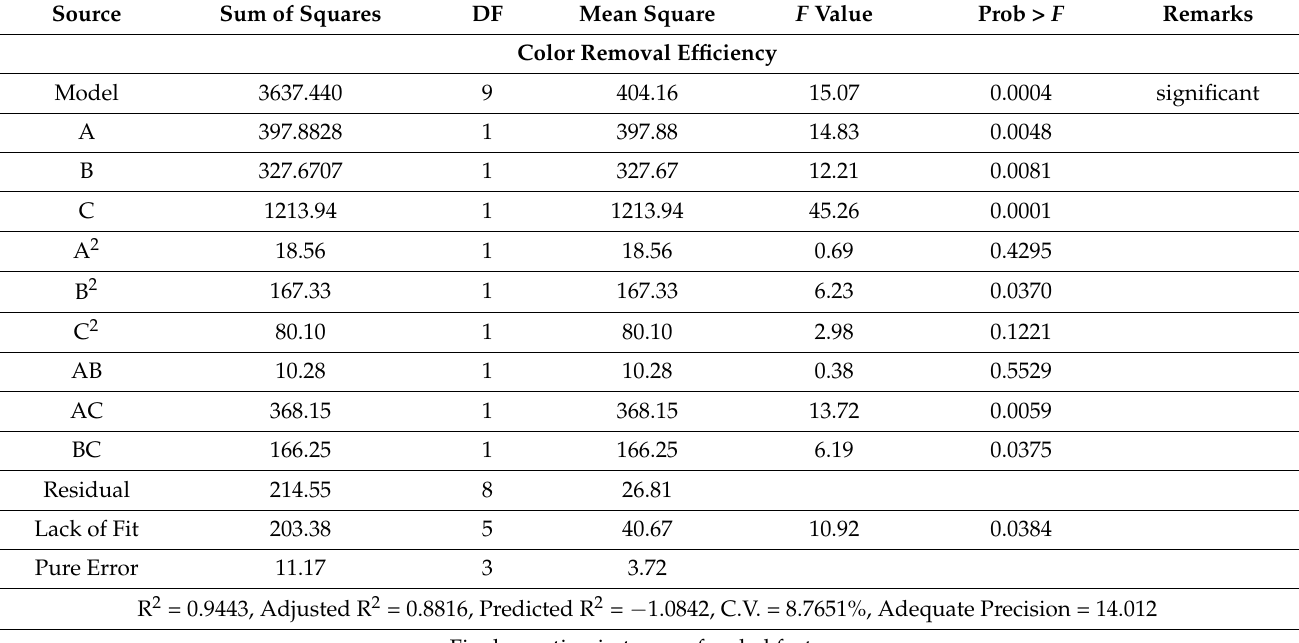
Final equation in terms of coded